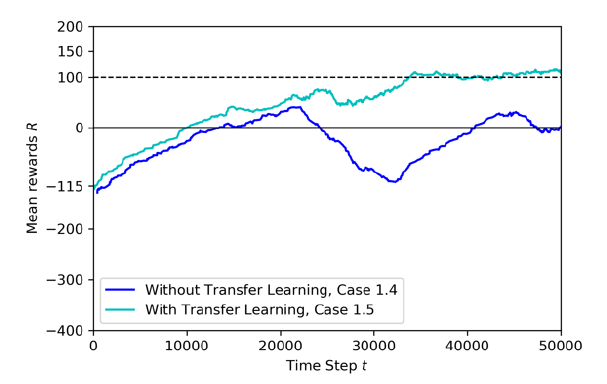
Figure 17. Training mean rewards for Case 1.3 and Case 1.4.